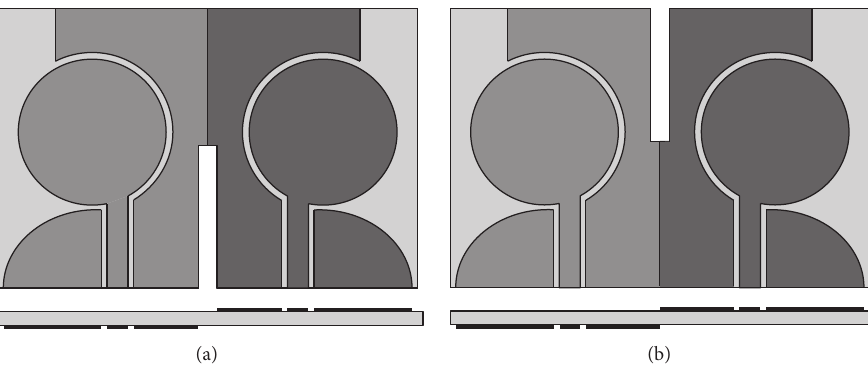
Figure 36: Geometry of the cross-configured directional UWB antenna [55]. The two structures (a) and (b) used to achieve a cross- configuration antenna are shown in figure. The radiation process takes place in the region between the monopole and rounded ground